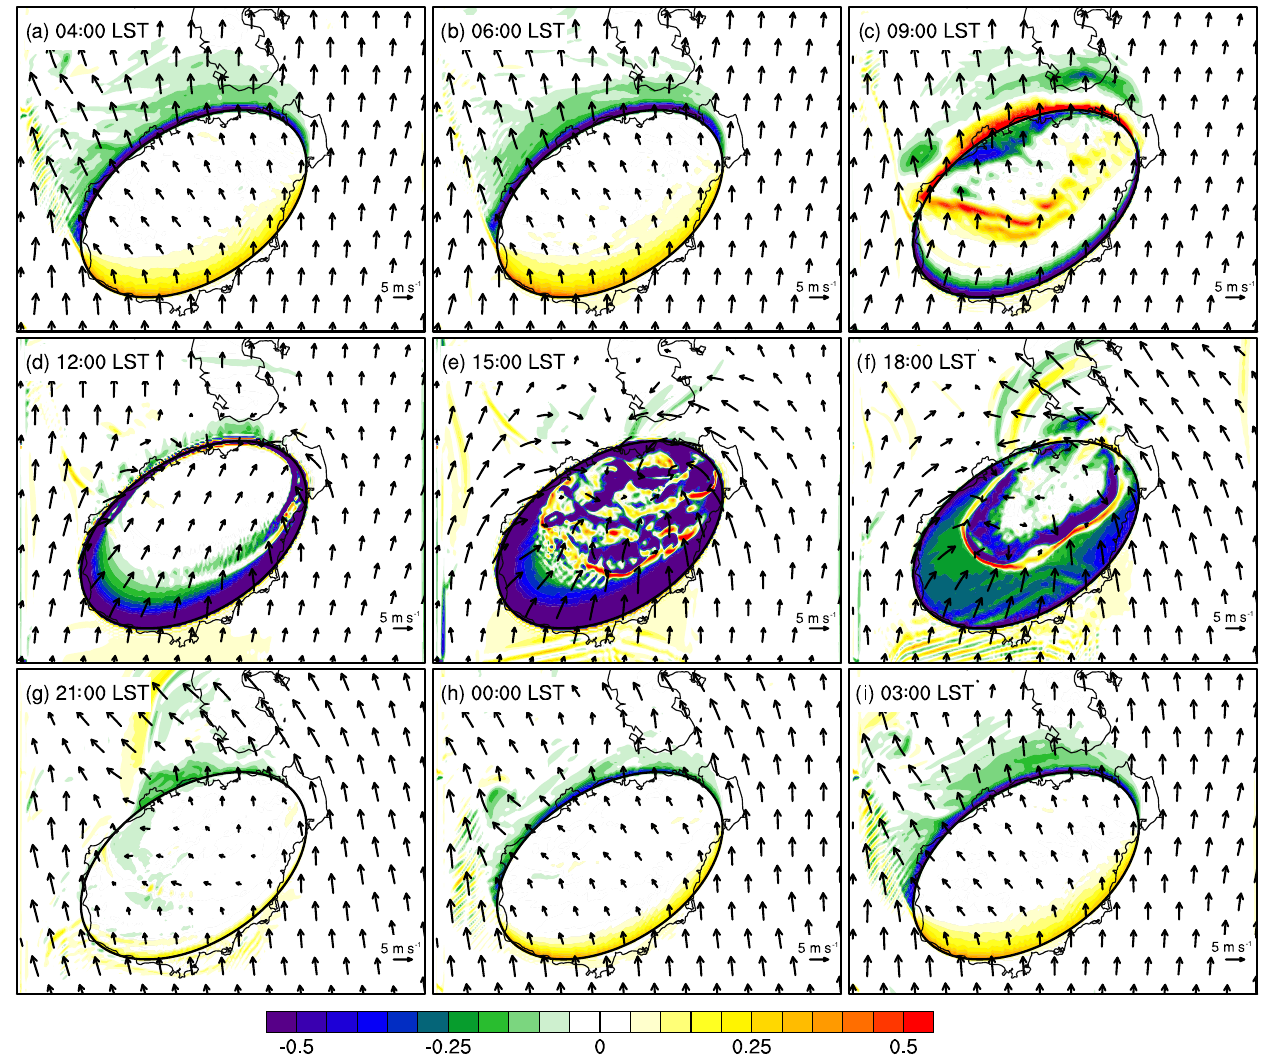
Figure 15. Horizontal temperature advection (shaded) and horizontal wind (vector, m s − 1 ) on the first model level in the IDEAL